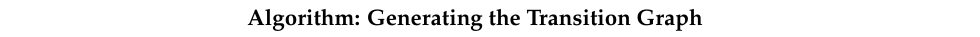
Table 2. An algorithm of generating the transition graph. Algorithm: Generating the Transition